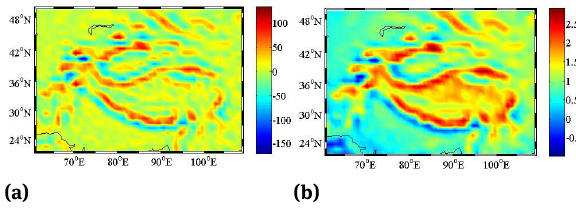
Figure 6: Map of a) ∆ g generated from VMM and FLEX models ( ∆ g VMM2 ) . b) Differences between ∆ g SVMM2 and ∆ g VMM2 [mGal]